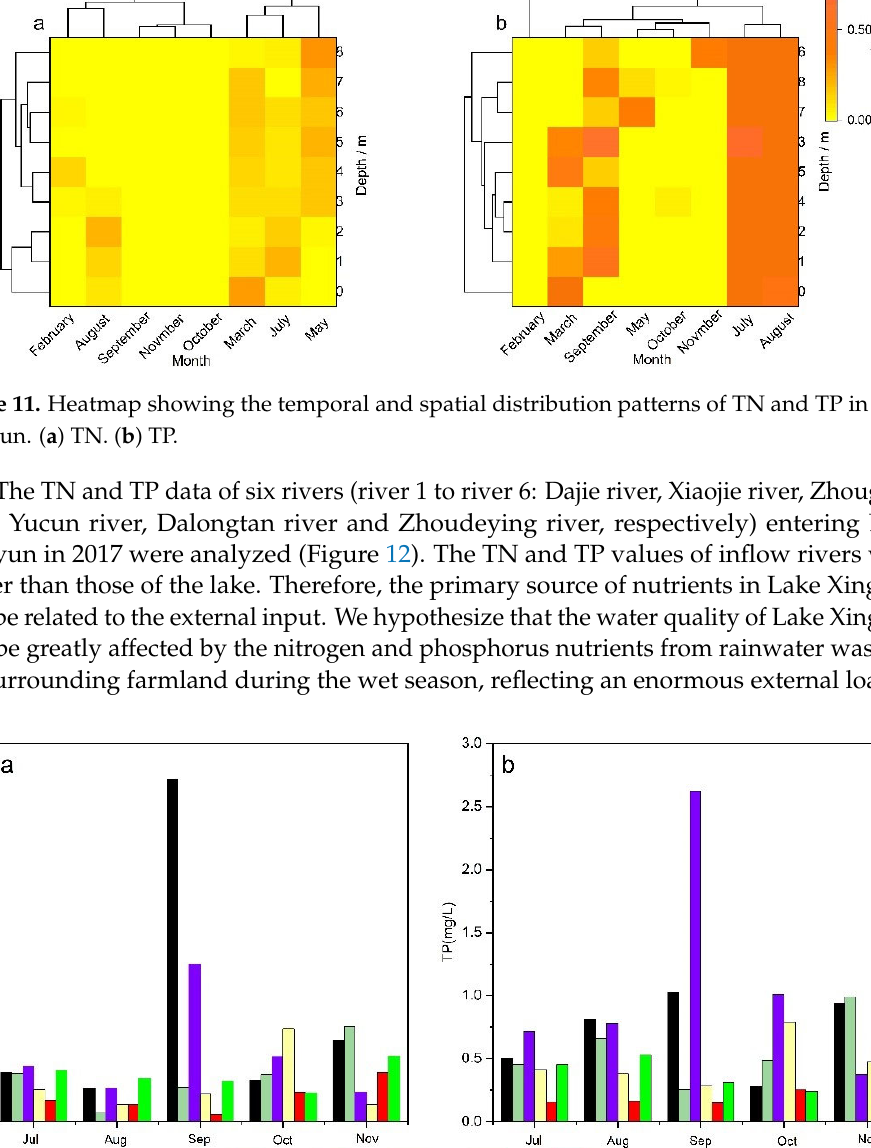
Figure 10. Heat map of the temporal and spatial distribution of water quality in Lake Xingyun in